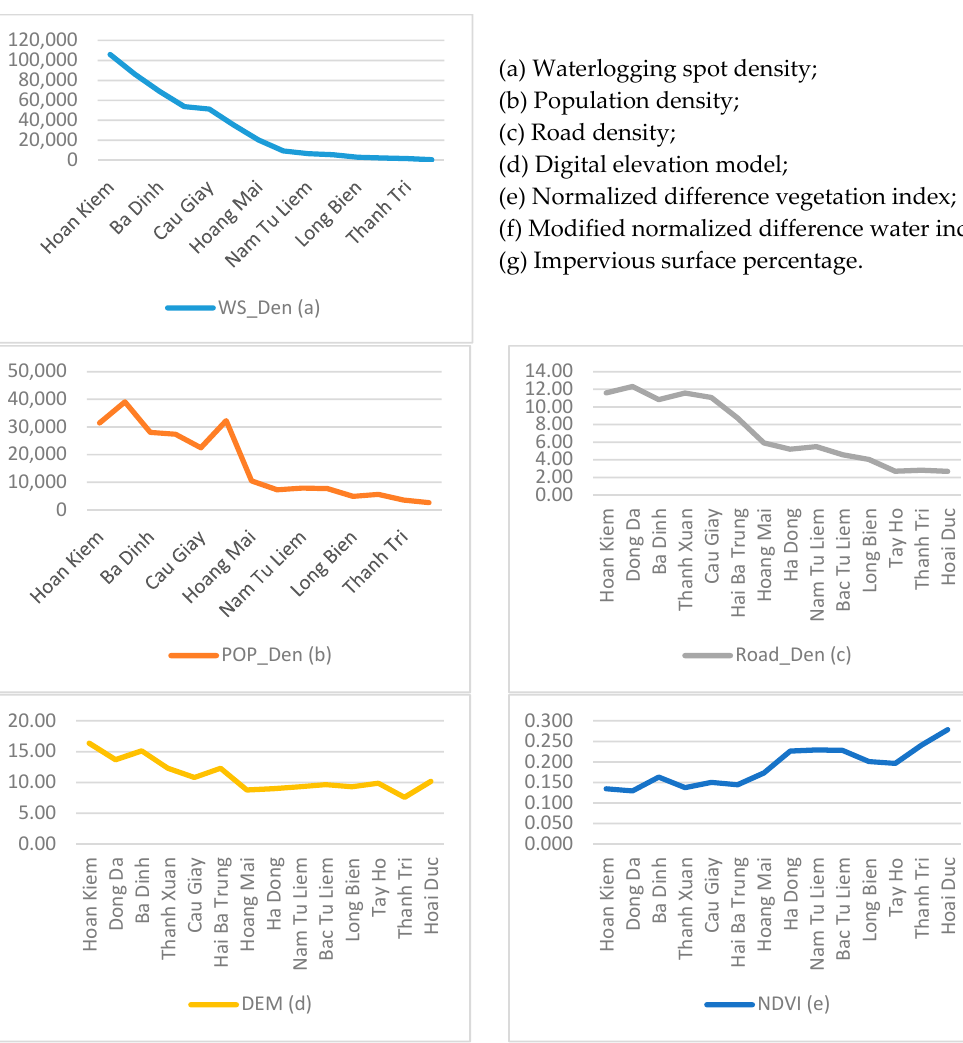
Figure 7. Hotspot analysis map.